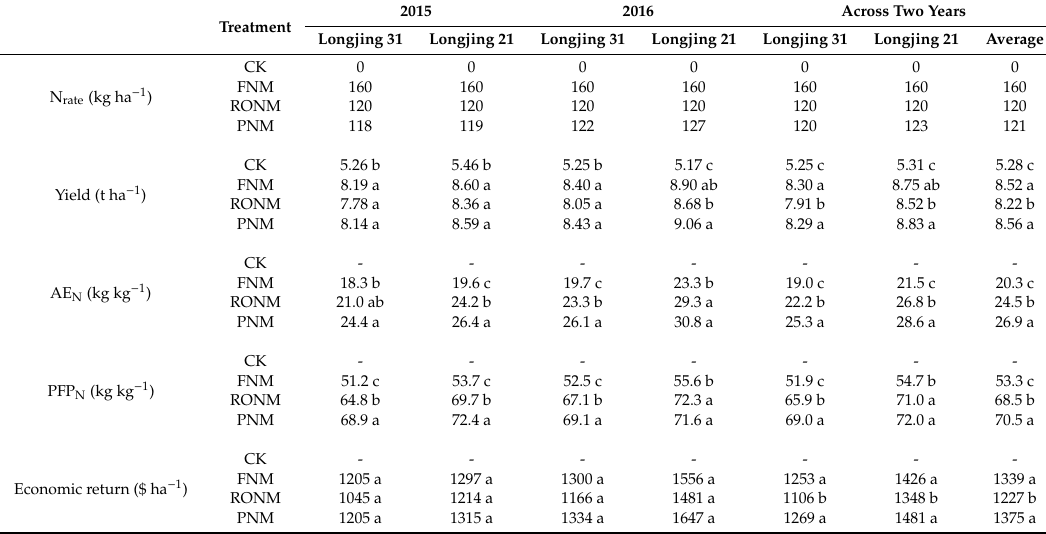
Table 6. N application rate (N rate ), grain yield, agronomy e ffi ciency of N (AE N ), partial factor productivity of N (PFP N ), and economic returns of di ff erent rice N management strategies in the evaluation experiments conducted in 2015 and